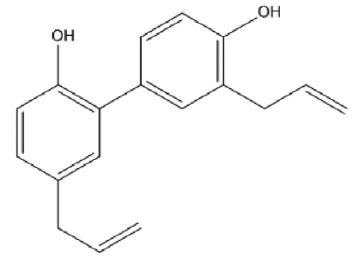
Figure 1. Chemical structure of honokiol.